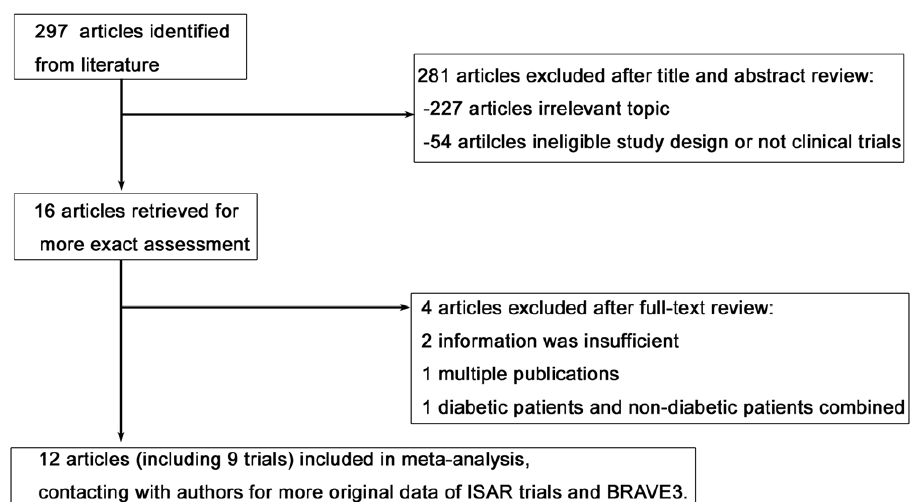
Figure 1. Selection of studies included in systematic review.